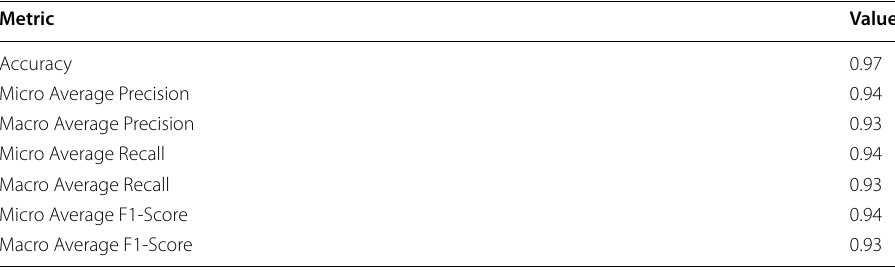
Table 14 Values of some quality metrics obtained by applying our classification algorithm with an exhaustive examination of all the possible weight combinations for the Eros distance